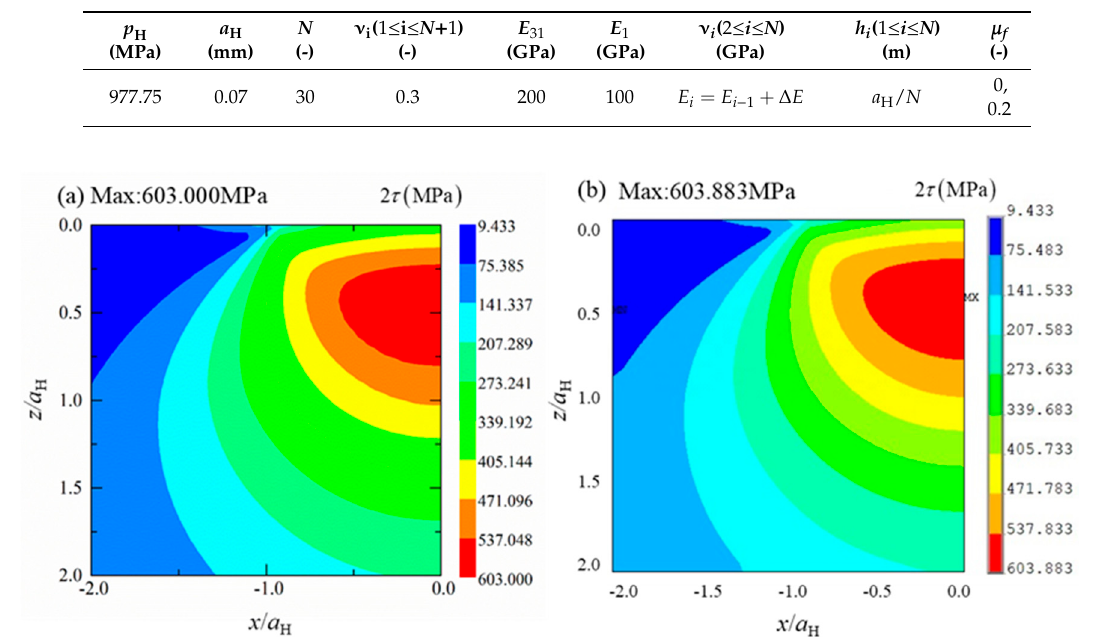
Table 2. Input parameters of the present method for simulating a half-space coated with 30 layers